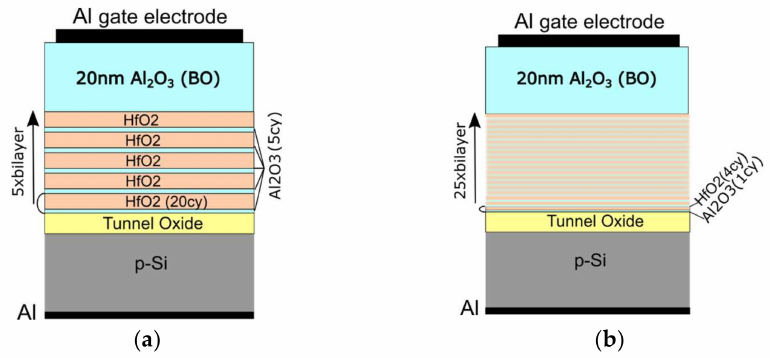
Figure 1. Schematic presentation of the memory capacitors with: ( a ) nanolaminated and ( b ) doped charge trapping